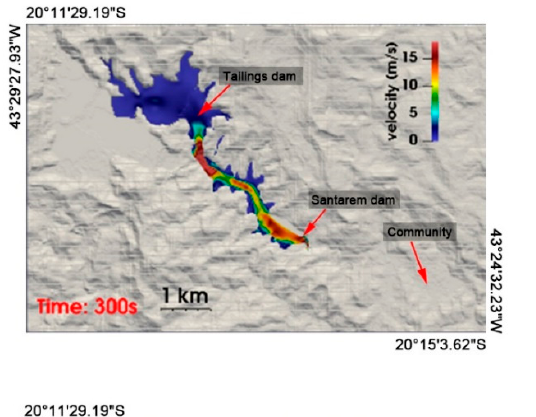
Figure 9. Numerical results of submerged depth, velocity and impact pressure at Bento Rodriguez.